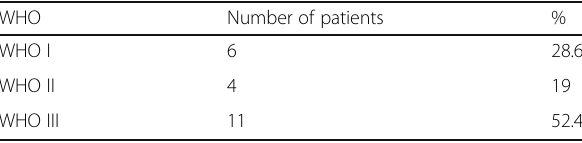
Table 3 Pathology/WHO